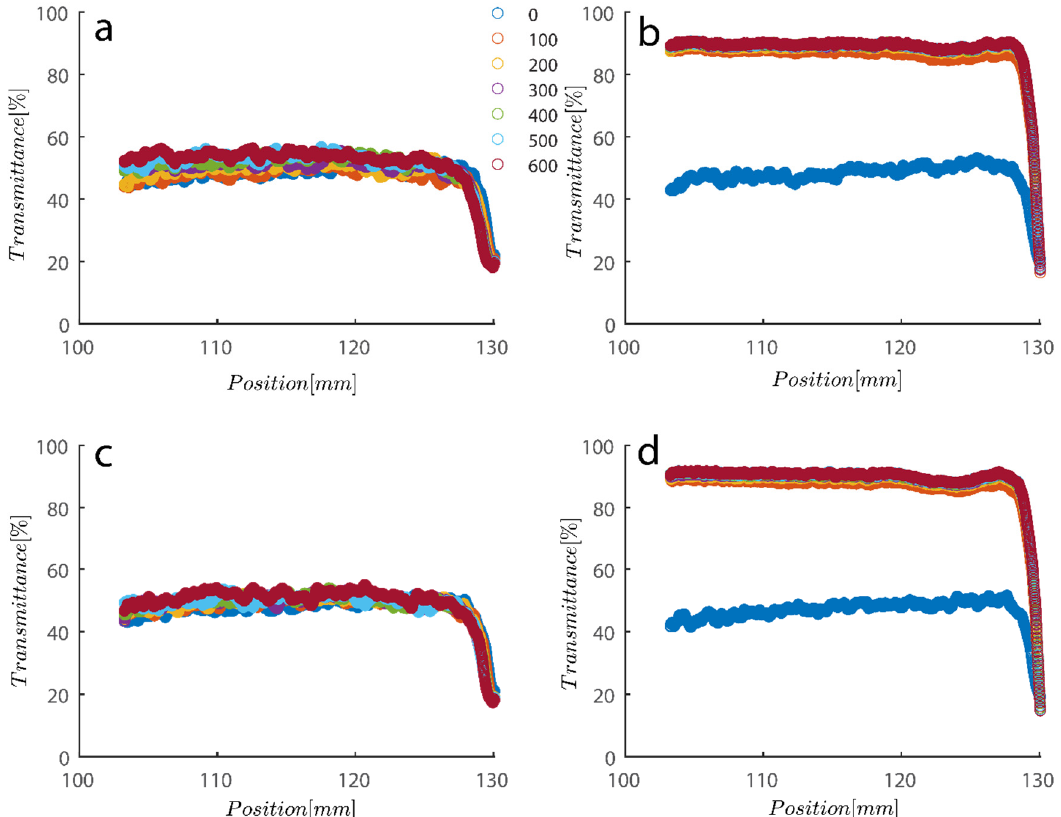
Figure 8. Transmission profiles obtained during centrifugation of a kaolinite sample Sigma I ( a ) 200, ( b ) 4000, ( c ) 200, ( d ) 4000 RPM. At 0.1 wt% concentration with ( a – c ) 7.5 ppm PAM and ( b – d ) 15 ppm PAM added into the mix. The position of the illuminated cell varies between 103–130 nm; the low transmission at the end of the cells demonstrates that particles are accumulating there.